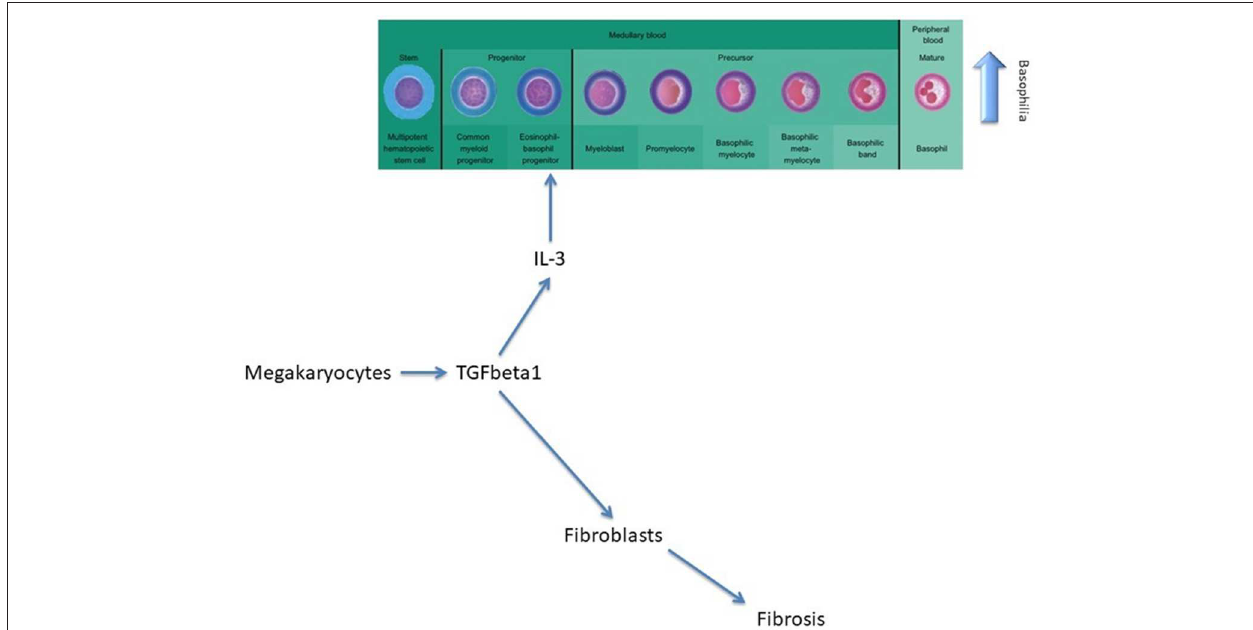
FIGURE 3 | The role of mutational background in modulating basophilia for primary myelofibrosis that evolvs towards acute myeloid leukemia.